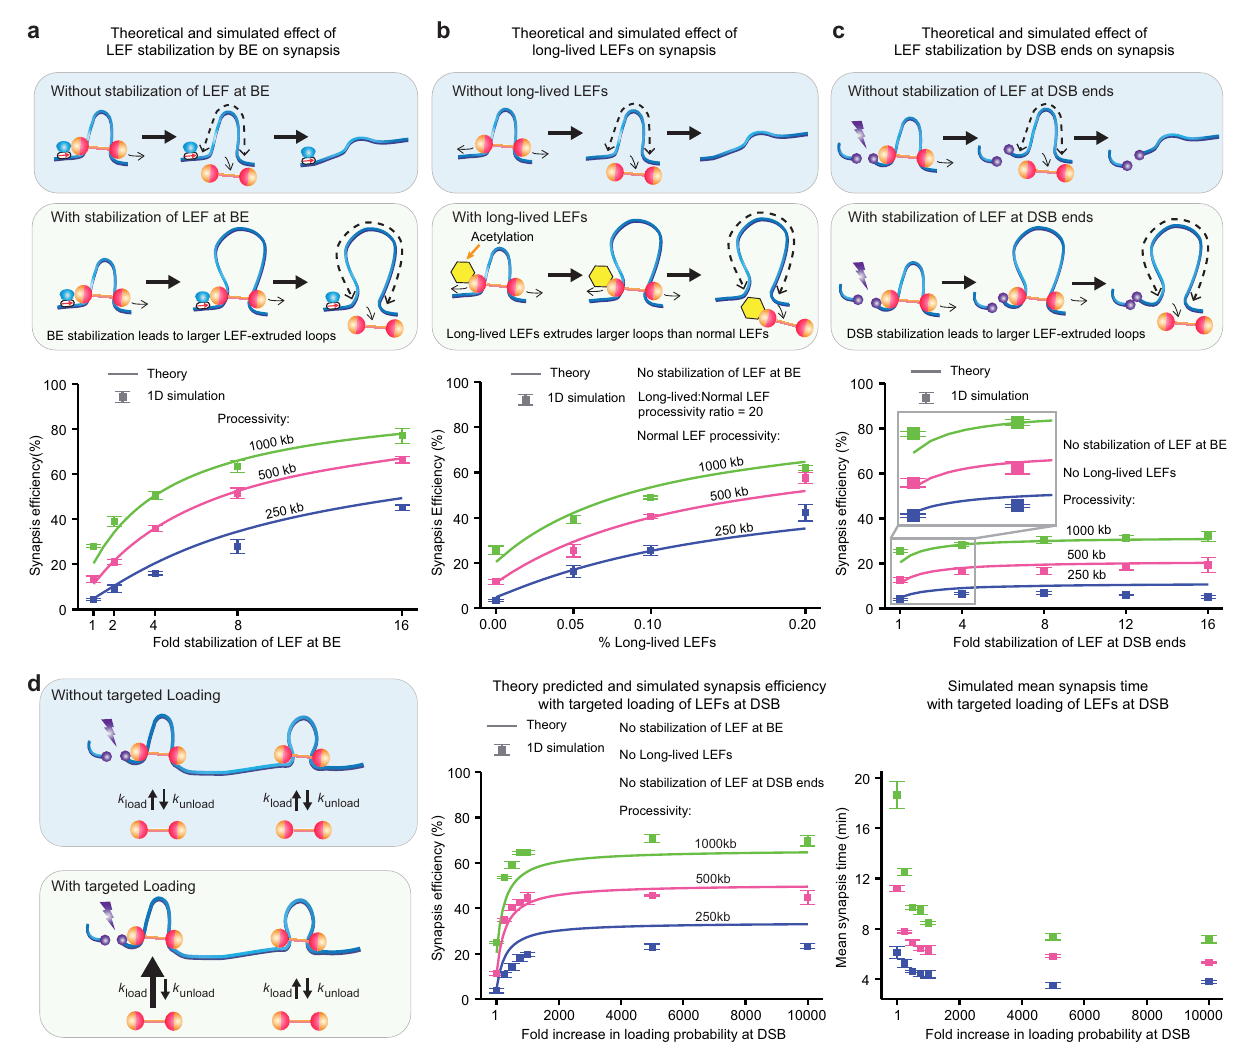
Fig. 4 | LEF stabilizationby either BEs orDSBs improves synapsis ef fi ciency, as does the presence of long-lived LEFs and targeted loading of LEF at DSB. a – c Schematic diagrams of the effects of stabilization of LEFs by BE, having a small portion of long-lived LEFs, and stabilization of LEFs by DSB (top), and the corre- spondingsynapsisef fi ciency(bottom)predictedbytheory(lines)orobtainedfrom 1D simulations (squares; the error bars represent the standard error of the mean, n =3 independent 1D simulations, with 216 – 218 DSB events per simulation). LEF separationof125kbandboundarystrengthof0.5wereused.Theinsetin( c )shows the modest but statistically signi fi cant improvement in synapsis ef fi ciency when